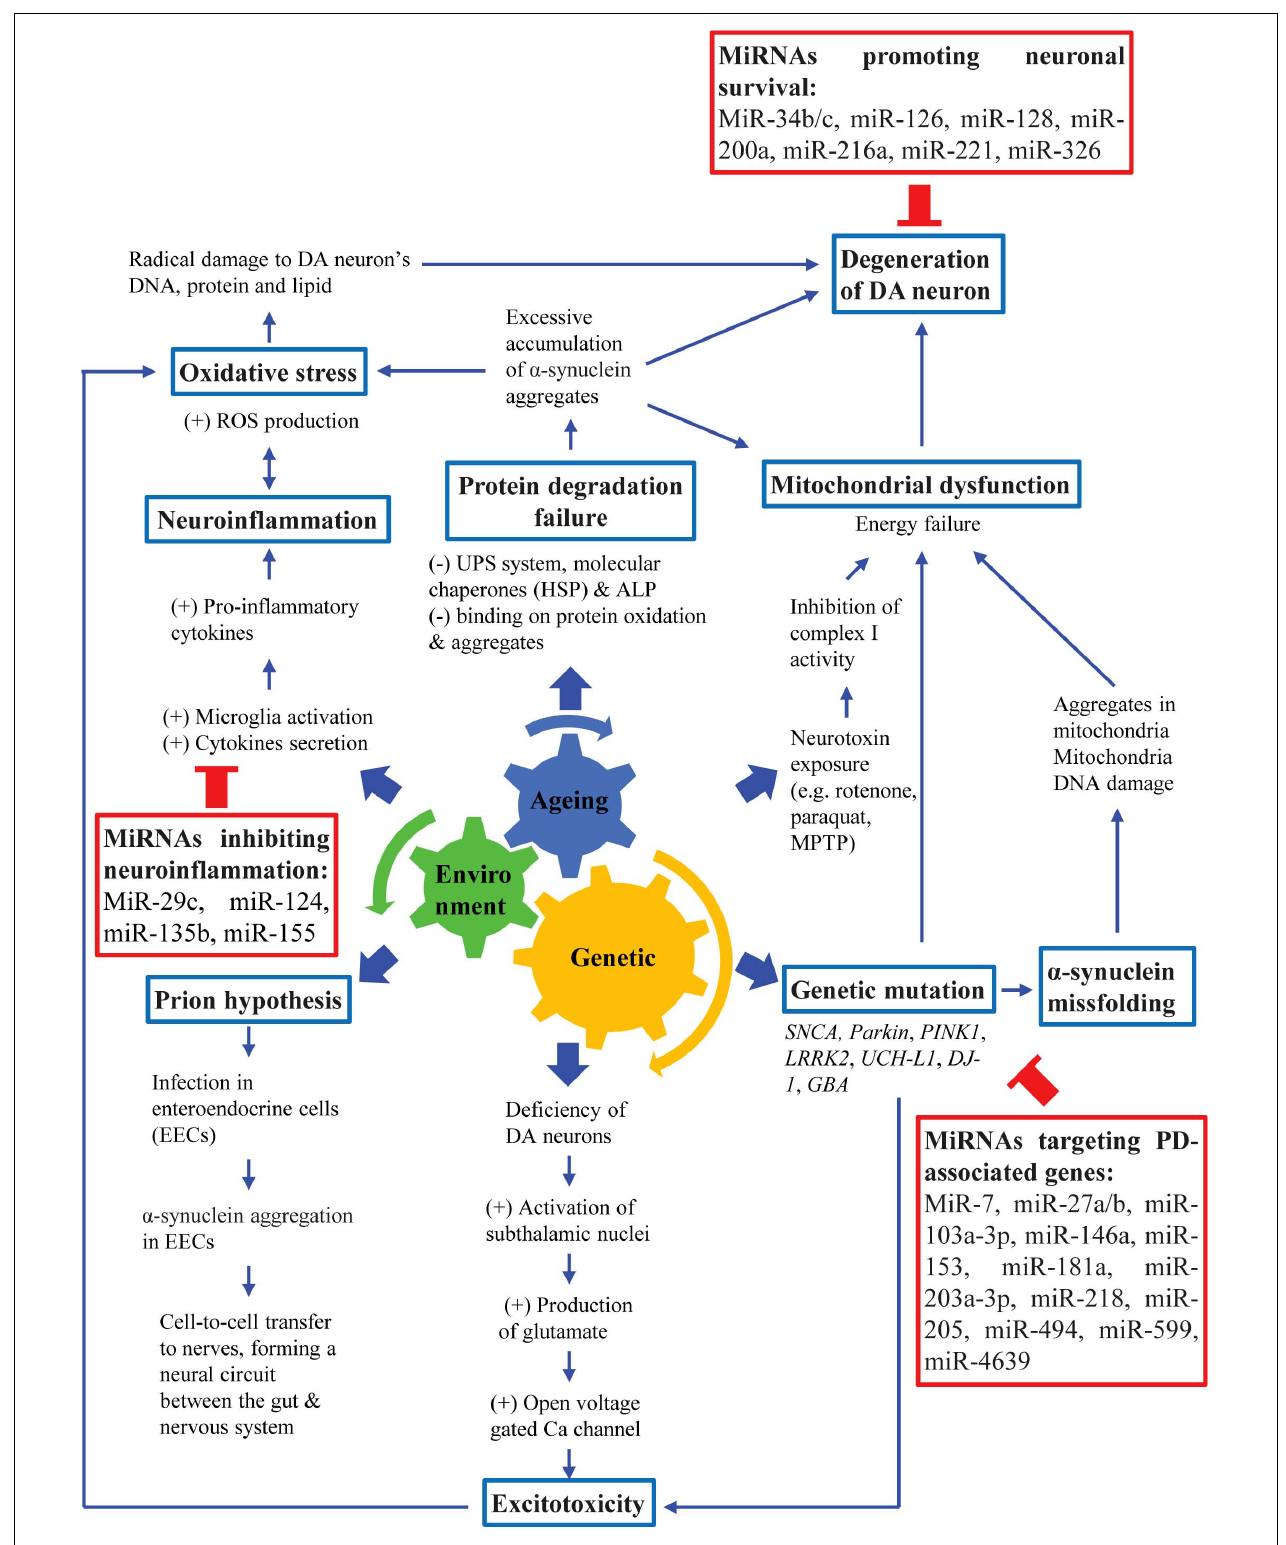
FIGURE 1 | Pathogenesis of PD. PD pathogenesis involves an interplay among aging, genetic susceptibility and environmental factors, leading to loss of DA neurons which eventually lead to cardinal motor symptoms of PD.